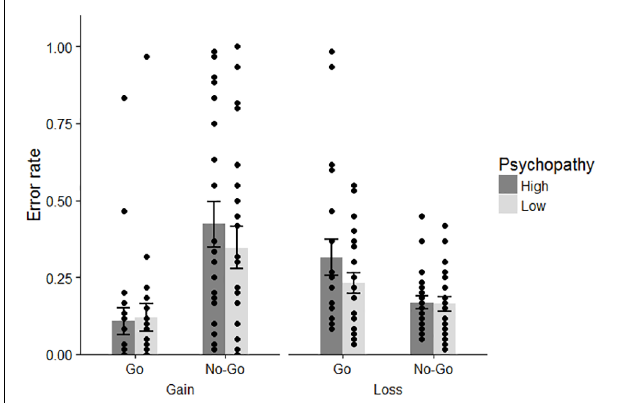
FIGURE 2 | Error rates in each condition for both groups. Dots indicate the data for each participant. Error bars represent standard errors.